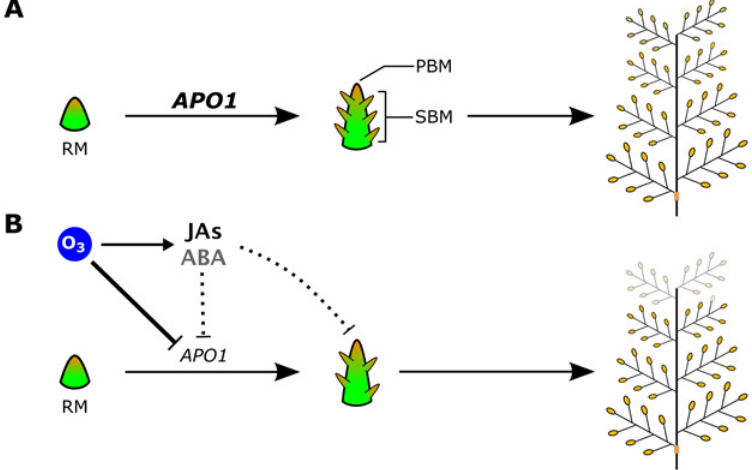
Fig 8. A hypothetical model of ozone-induced grain yield loss in Habataki. (A) Panicle formation flow under ambient air condition. The APO1 transcription is the trigger of phase transition from rachis meristems (RM) to primary and secondary branch meristems (PBM and SBM). The transcript level is higher in Habataki than Sasanishiki, this is the reason Habataki is high-yielding cultivar. (B) Ozone enters leaves through stomata and generates ROS, which triggers generation of JAs and ABA in leaves to attenuate leaf damage. ROS signaling suppress the APO1 transcript level directly or indirectly in Habataki. In parallel, phytohormones generated in leaves might be translocated to inflorescence meristems through the phloem. These impacts suppress differentiation of the RM into the PBM and SBM. Consequently, the decrease in primary rachis branch formation reduces grain